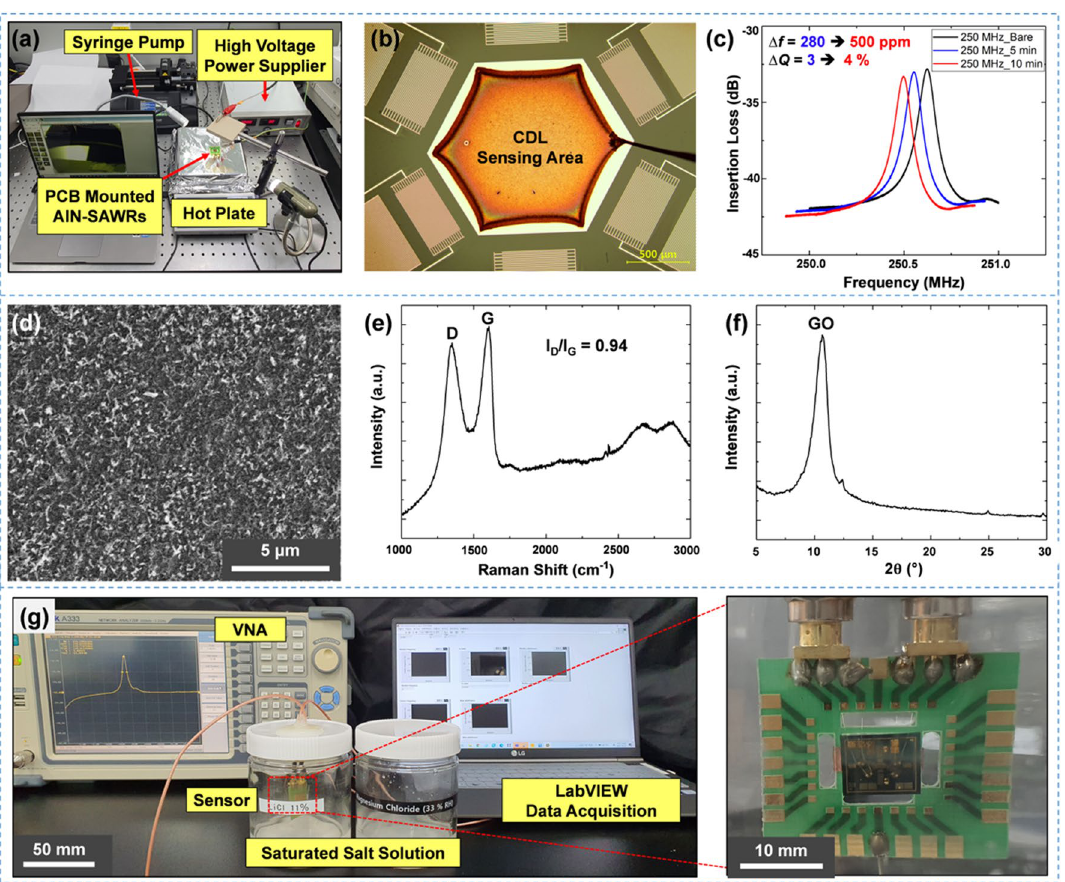
Figure 2. ( a ) The digital image of the ESD setup consisting of the syringe pump, high voltage supply, and hot plate. ( b ) The optical microscope image of coated GO film on CDL. ( c ) The resonant peak shift with GO spraying time for 250 MHz SAWR. ( d ) The scanning electron microscope (SEM) image of GO film. ( e ) Raman and ( f ) XRD analysis of coated GO film. ( f ) Experimental setup for testing SAWR humidity sensor consisting of VNA, LabVIEW connected PC, and saturated salt solution chamber. ( g ) The PCB mounted SAWR for an electrical